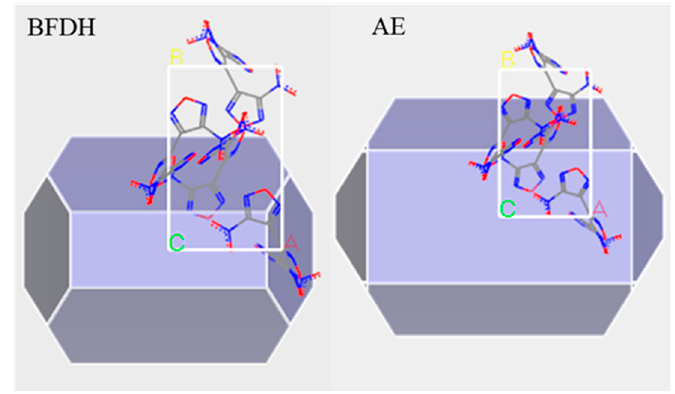
Figure 1. Vacuum growth morphology of DNTF. Table 1. Natural growth of DNTF crystals crystal surface data.